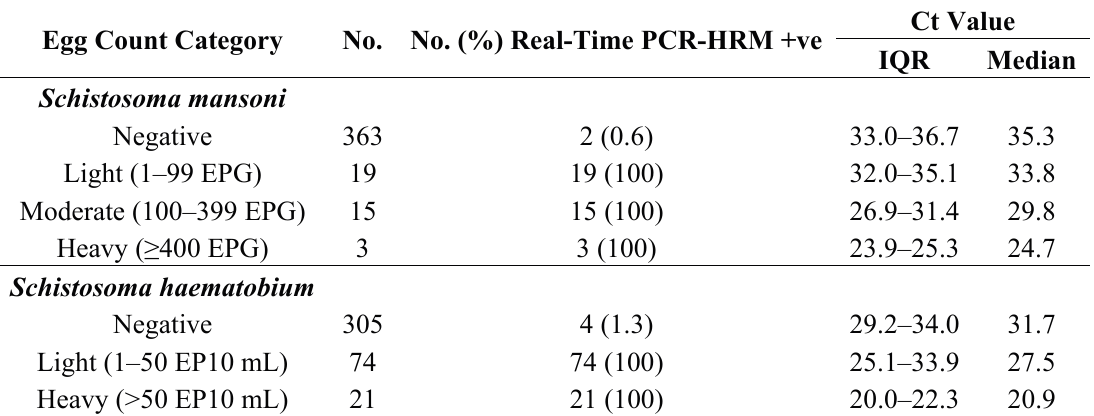
Table 3. Comparison of S. mansoni- and S. haematobium- specific real-time PCR-HRM according to eggs categorised by number of egg